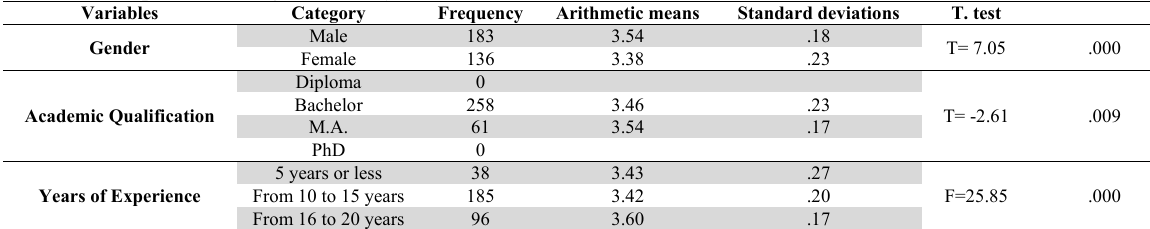
A t-test of samples and a single-test